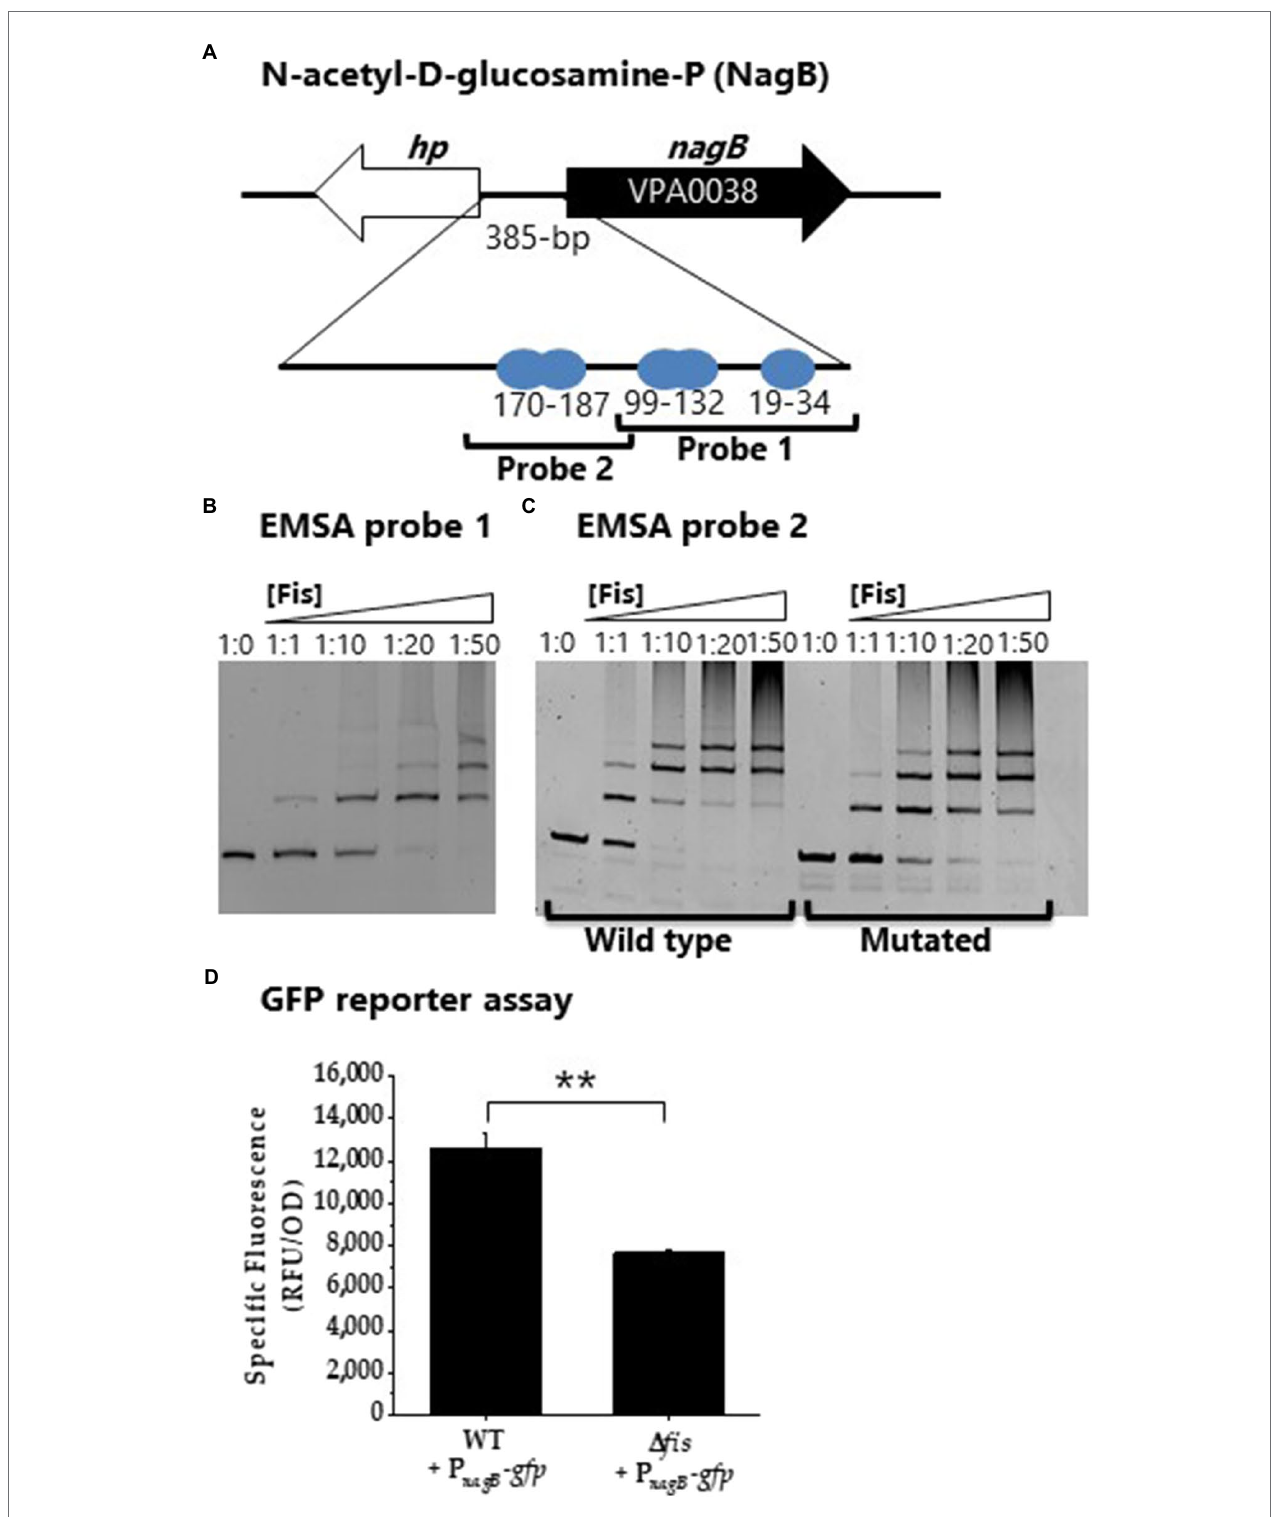
FIGURE 10 | Fis is a positive regulator of NAG gene nagB . (A) Fis binding sites identified in the regulatory region of nagB . (B) EMSA analysis of Fis binding to probe 1. (C) EMSA analysis of probe 2 and a mutated Fis BS probe 2. DNA: protein molar ratios were as follows: 10, 1:1, 1:10, 1:20, 1:50. (D) GFP transcriptional reporter assay with P nagB - gfp . Means and standard deviations of two biological replicates are shown. Statistics calculated using a Student’s t -test (** p <